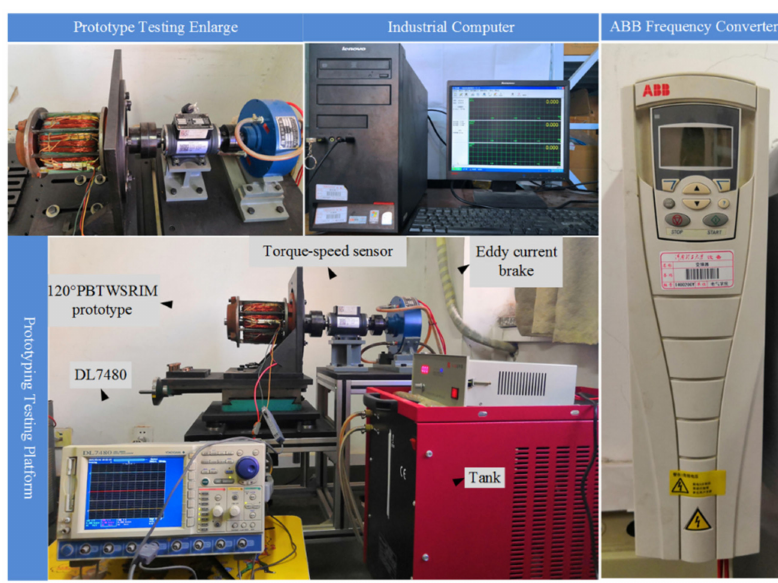
Figure 13. Prototype manufacturing process.